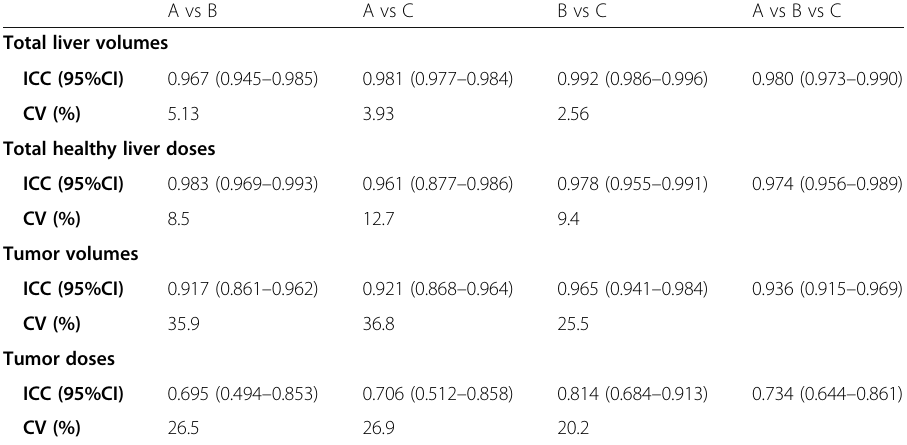
Table 2 Summary of agreement test results for TLV, THLD, TV, and TD